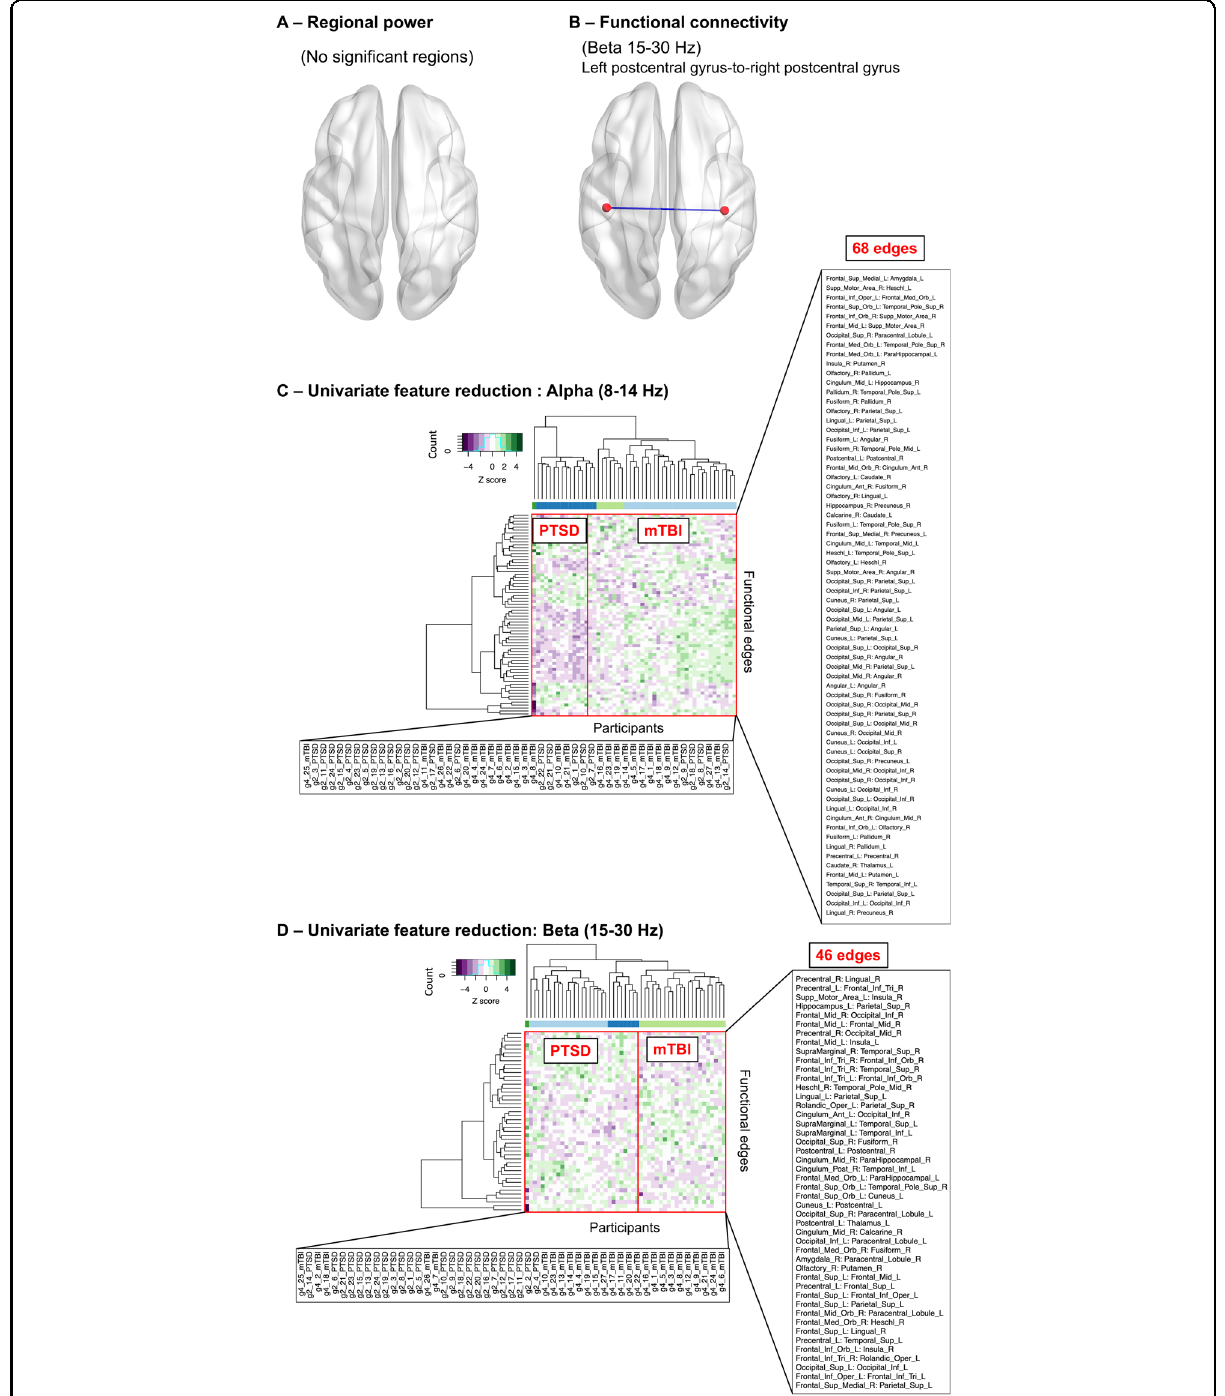
Fig. 2 Univariate statistical analysis and univariate feature reduction hierarchical clustering analysis. A , B Univariate analyses only reveal group differences in connectivity, and no regional change. A Regional power did not show any signi fi cant effects (correct for multiple comparisons), whereas B functional connectivity, for the beta band, shows only a single signi fi cant connection connecting the left postcentral gyrus-to-right postcentral gyrus. C , D Unsupervised hierarchical clustering results show univariate reduced data led to better group separation with the functional connectivity data. The fi gure shows the ( C ) alpha and ( D ) beta bands as examples, with the PTSD vs mTBI contrast. The dendrograms show the clustering for the participants (horizontal) and the univariate reduced features (vertical) based on the Z scores for AEC. The colour bar below the horizontal indicates the major (top three levels) participant clusters. The number of univariate reduced features are marked. Both C and D showed that, although with some exceptions, the univariate feature reduction helped reduce the functional connectivity data into features that separated the participants into PTSD and mTBI